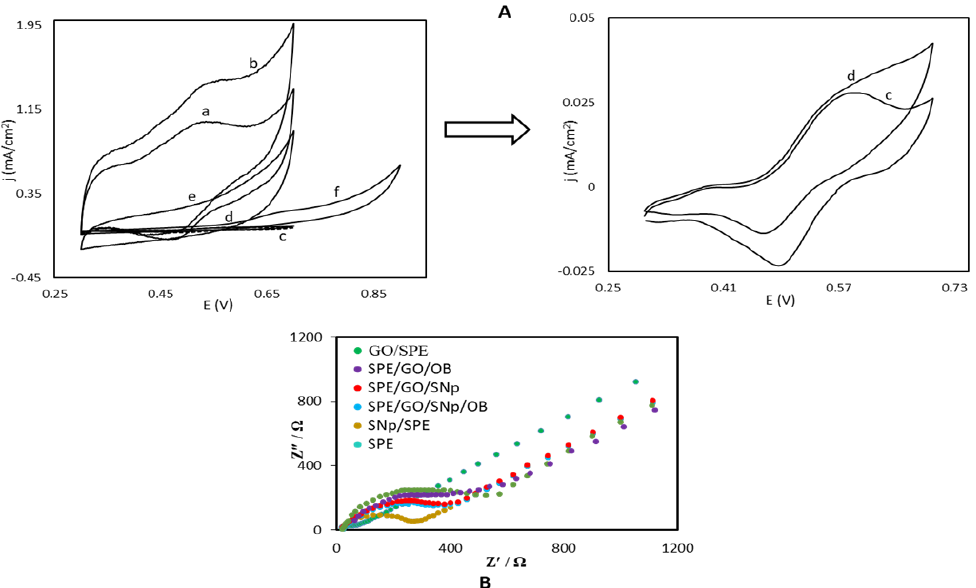
Figure 3. ( A ) Cyclic voltammograms of OB/SNPs/GO/SPE in the absence (a) and presence (b) of 0.1 mM STR. Cyclic voltammograms of SNPs/GO/SPE (c) and OB/GO/SPE (d) in the presence of 0.1mM STR. (e,f). As (b) for SNPs/SPE, and GO/SPE, conditions: 0.1 M phosphate buffer solution pH = 7.0 at scan rate 20 mV·s −1 . ( B ) Electrochemical impedance spectroscopy of the electrode for SPE, GO/SPE, SNPs/SPE, SNPs/GO/SPE, OB/GO/SPE, and OB/SNPs/GO/SPE .